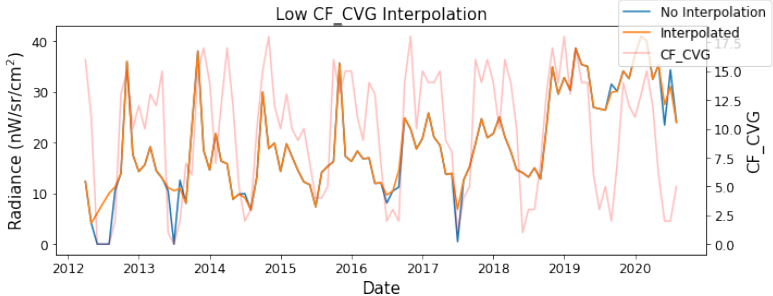
Figure 6. Interpolation for low cloud-free coverage (CF_CVG) records.